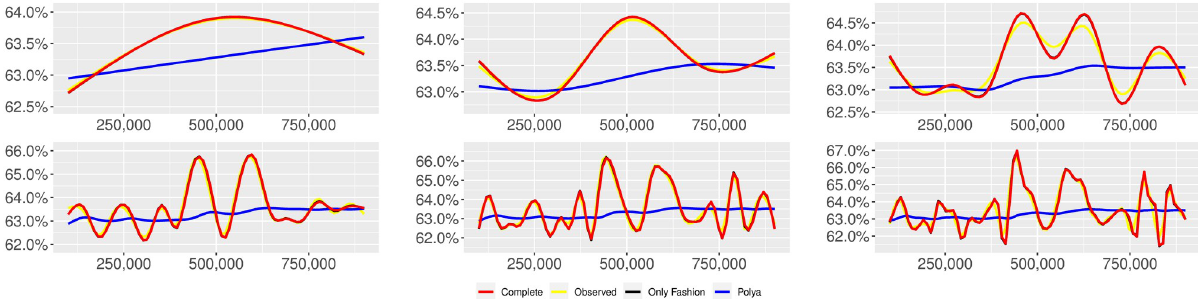
Fig 3. “10 days of traffic” ( T = 0.35, entire, D = 30 00 , S = 100 slots of equal size): Sentiment curves. In each panel, the yellow line is the cubic spline smoothing of the time series of the observed tweets ξ , together with the default confidence interval (gray), the red line represents the cubic spline n +1 smoothing of the time series of the estimated predictive means ^ c (defined in Subsec. 3.2), obtained with the complete RP model, the black and the blue n lines provide similar approximations obtained with the other models: black = Only fashion RP model and blue = Standard Po´lya model. In each panel, the smoothing is obtained with a given number of nodes: k = 3 (top left panel), 5 (top middle panel), 10 (top right panel), 20 (bottom left panel), 30 (bottom middle panel), 50 (bottom right panel).